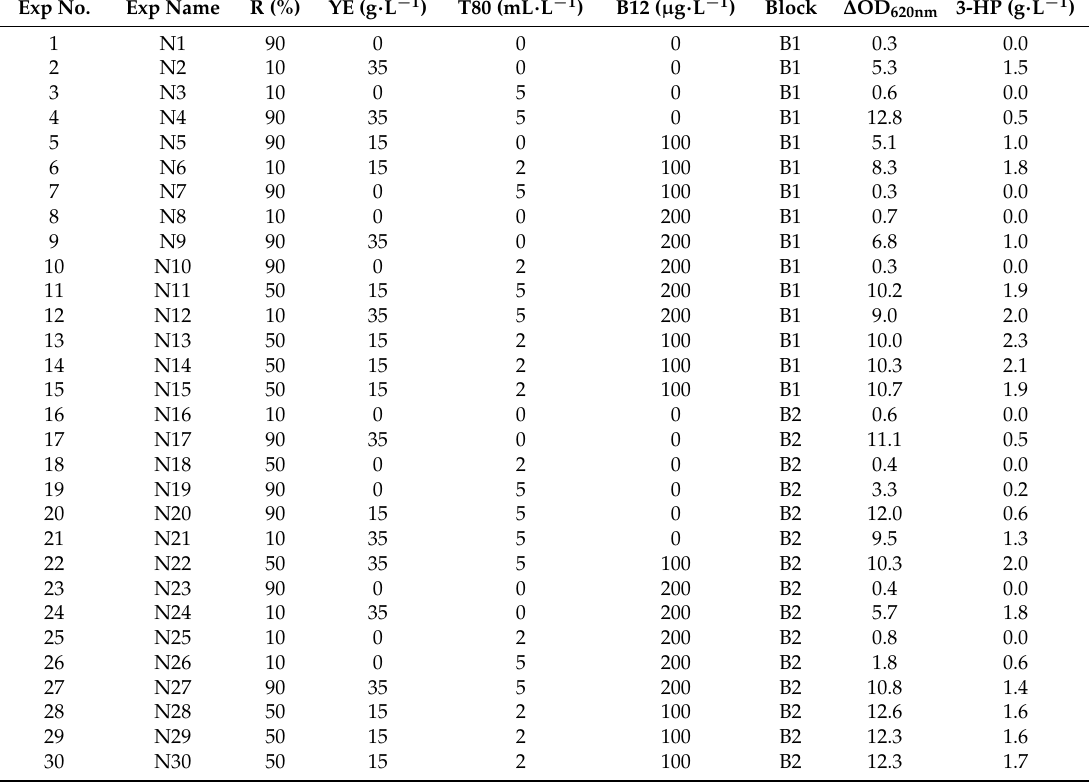
Table 1. Experimental design and responses. R: percentage of LPS in the carbon source, YE: yeast extract concentration, T80: Tween 80 concentration, B12: cyanocobalamine concentration, ∆ OD 620nm : optical density at 620 nm, 3-HP: 3-hydroxypropionic